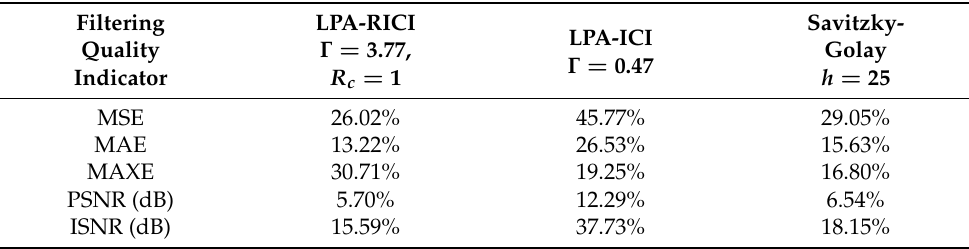
Table 33. Piece-Regular signal (SNR = 7 dB)—Filtering quality improvement of the RBF-RICI-based filtering over other tested algorithms.